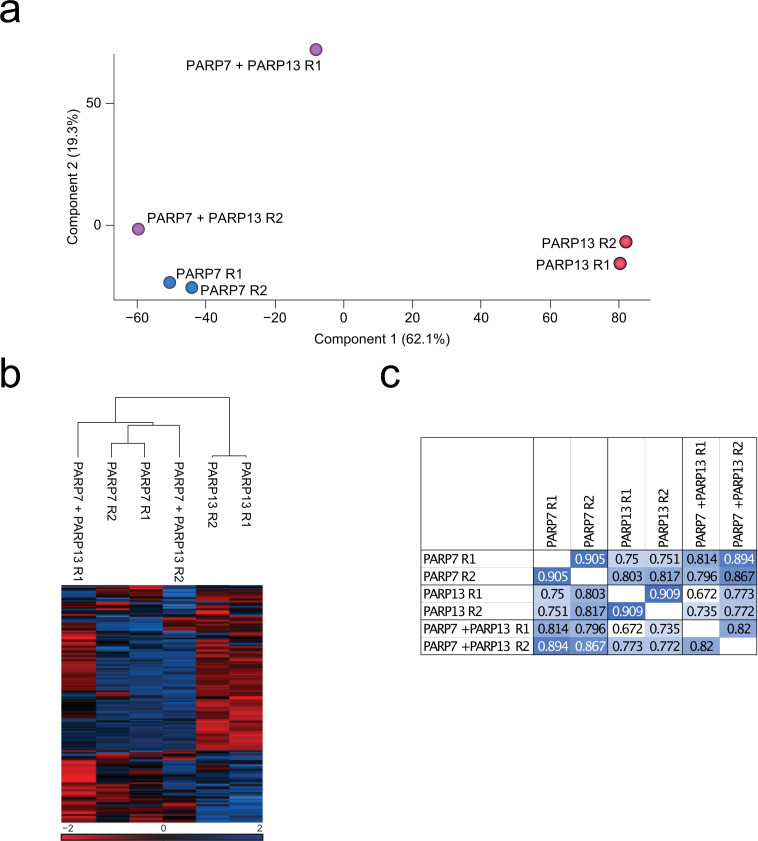
EThcD sample correlation data.(a) Principal component analysis (PCA) based upon unnormalized data. Blue; PARP-7 overexpressing replicates, red; PARP-13.2 overexpressing replicates, purple; PARP-7 and PARP-13.2 overexpressing replicates. (b) Unsupervised hierarchical clustering analysis of z-scored log2-transformed intensities of ADPr sites. (c) Pearson correlations of identified ADPr sites (localization probability >0.90).